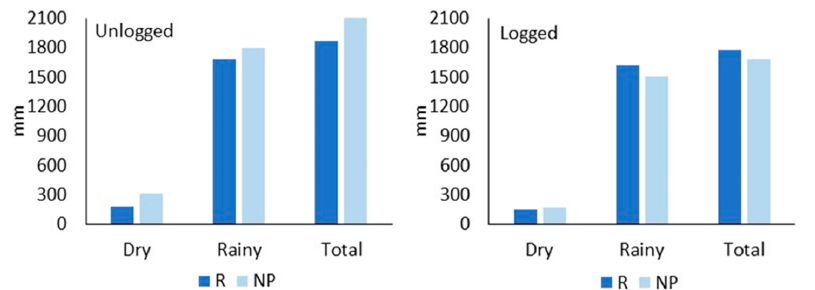
Figure 1. Open precipitation [R, mm] and net precipitation [NP, mm] partitioning in the dry